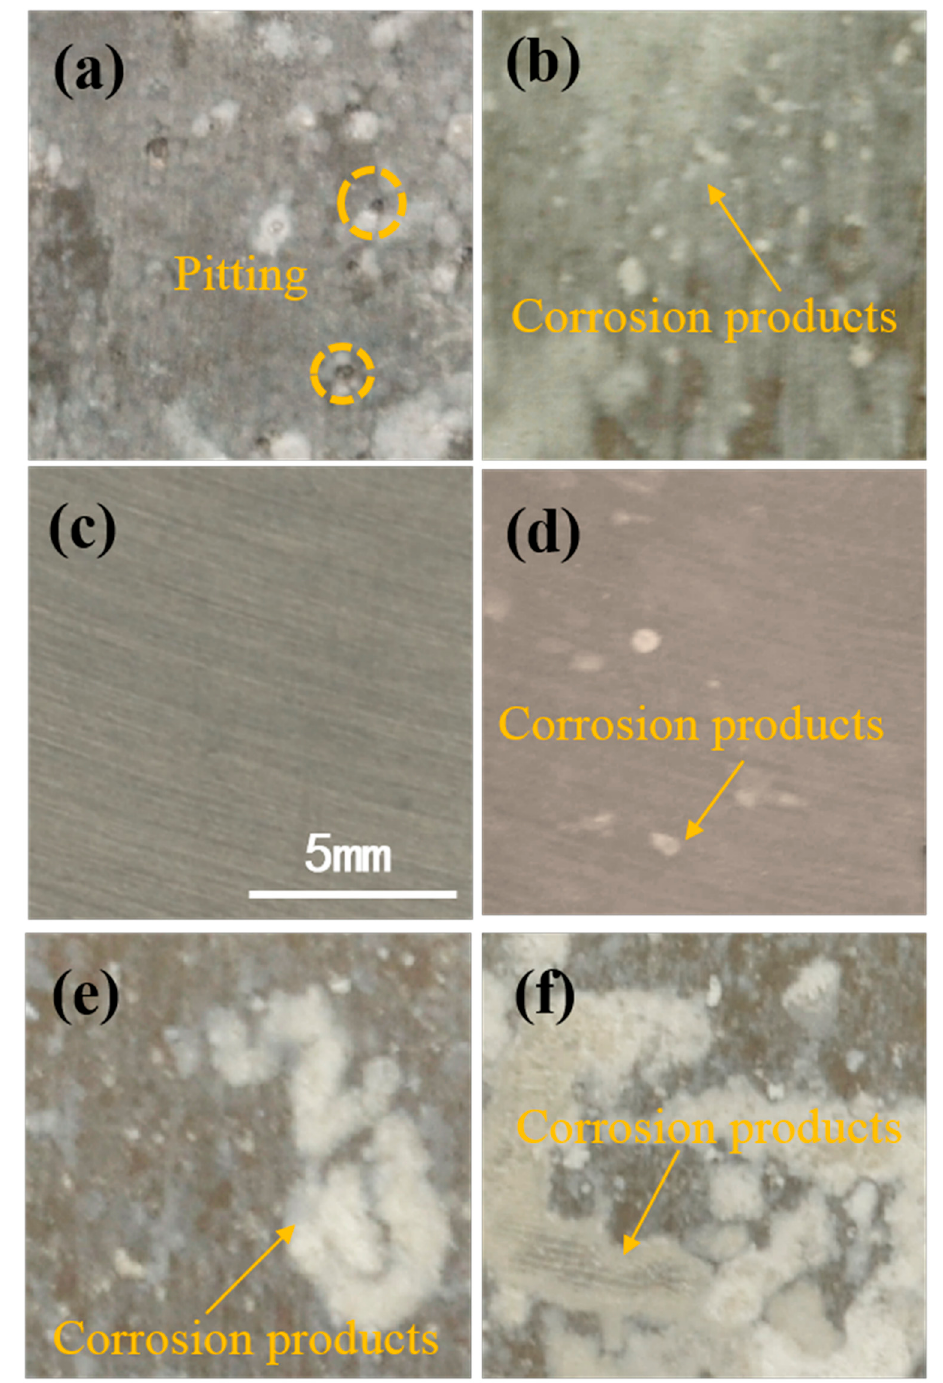
Figure 9. Macro images of corrosion morphology of the 5083 aluminum based alloy beneath coatings with different content of PANI-SSA ( a ) 0.1 wt. %; ( b ) 1 wt. %; ( c ) 2 wt. %; ( d ) 4 wt. %; ( e ) 6 wt. %; ( f ) 8 wt. % after immersion.